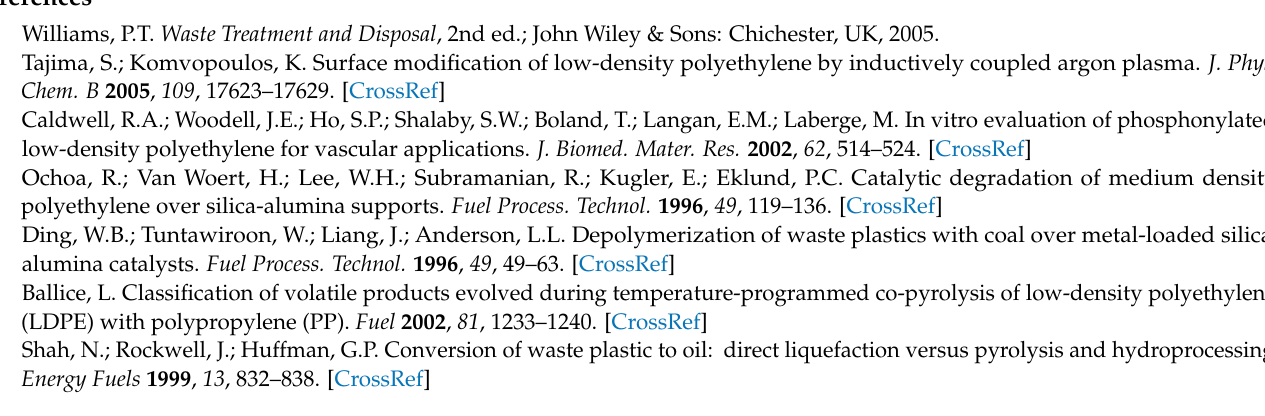
H-ZSM-11 after the pyrolysis of LDPE, Table S1: Specification, column information, and analytical conditions for the GC–MS, Table S2: Specification, column information, and analytical conditions for the micro-GC, Table S3: Physicochemical properties of the fresh H-ZSM-11 and the H-ZSM-11 after the pyrolysis of